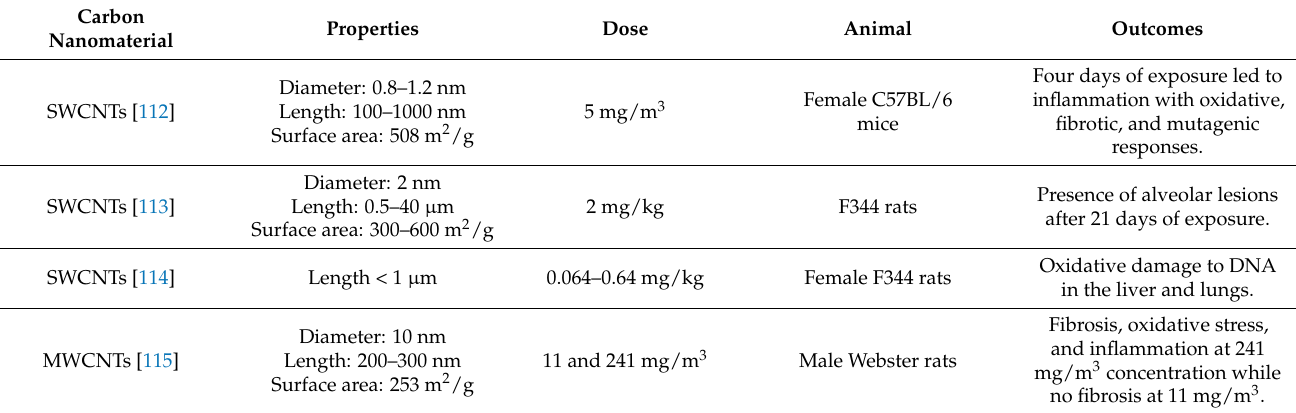
Table 6. Direct exposure of animals to carbon nanomaterials and the subsequent